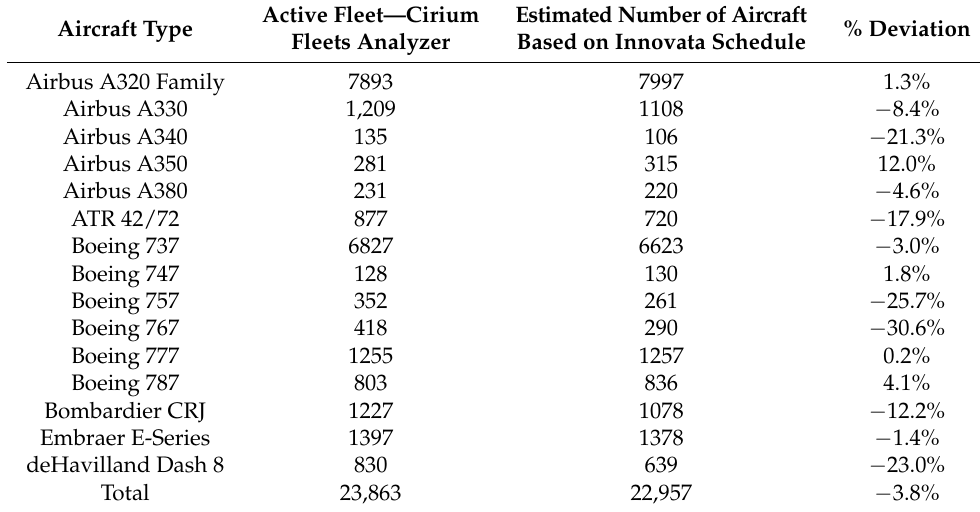
Table 2. Aircraft utilisation model accuracy (data from [45,47]).